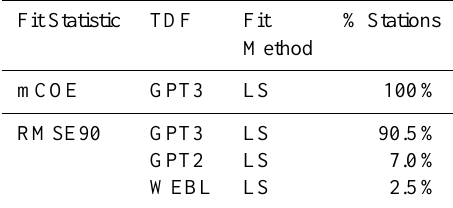
Table 4. Combination of TDF and fitting method with the highest fitting skill for mCOE and RMSE90 statistics, indicating the per- centage of stations for which each combination is the